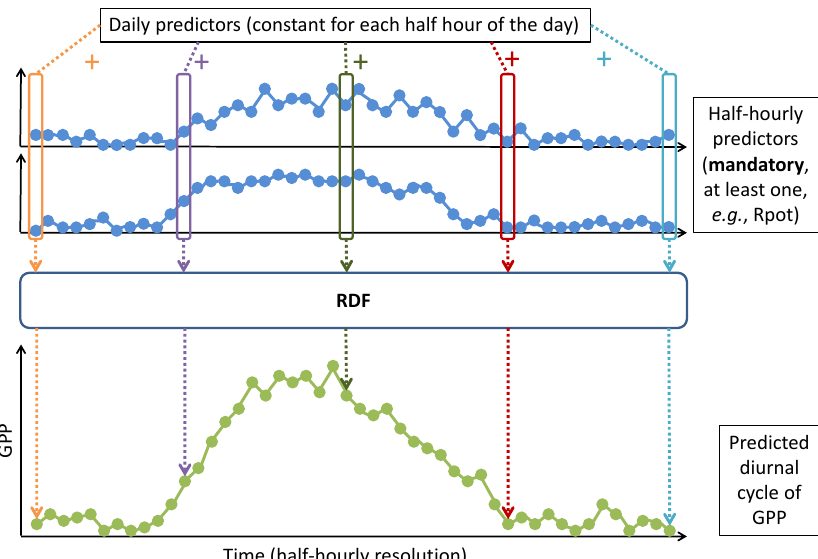
Figure 4. Visualization of the second prediction approach: a single RDF regression model is able to predict the flux at every half hour of the day if at least one predictor variable has a half-hourly temporal resolution (such as the potential radiation R pot ). This is different from the first prediction approach shown in Fig. 3, because the whole training data of all half hours are used to learn a single RDF regression model. The upper part of the figure shows the composition of the input data (predictor variables) that are required for predicting the half-hourly values of a single day. For each half hour, the corresponding values of the predictors with half-hourly resolution are added to the predictors with coarser temporal resolution (indicated by the vertical color bars). We then have 48 distinct samples due to the distinction from the half-hourly predictor variables and these samples are delivered to the single RDF regression model indicated by the arrows in the upper part. For each sample, the RDF model calculates an output value (lower part) that denotes the estimate for the corresponding half hour within the diurnal